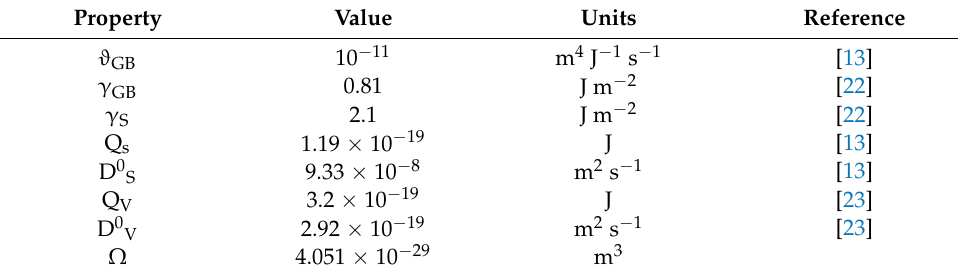
Table 2. Material properties of Ti6Al4V adopted for the PF simulations.